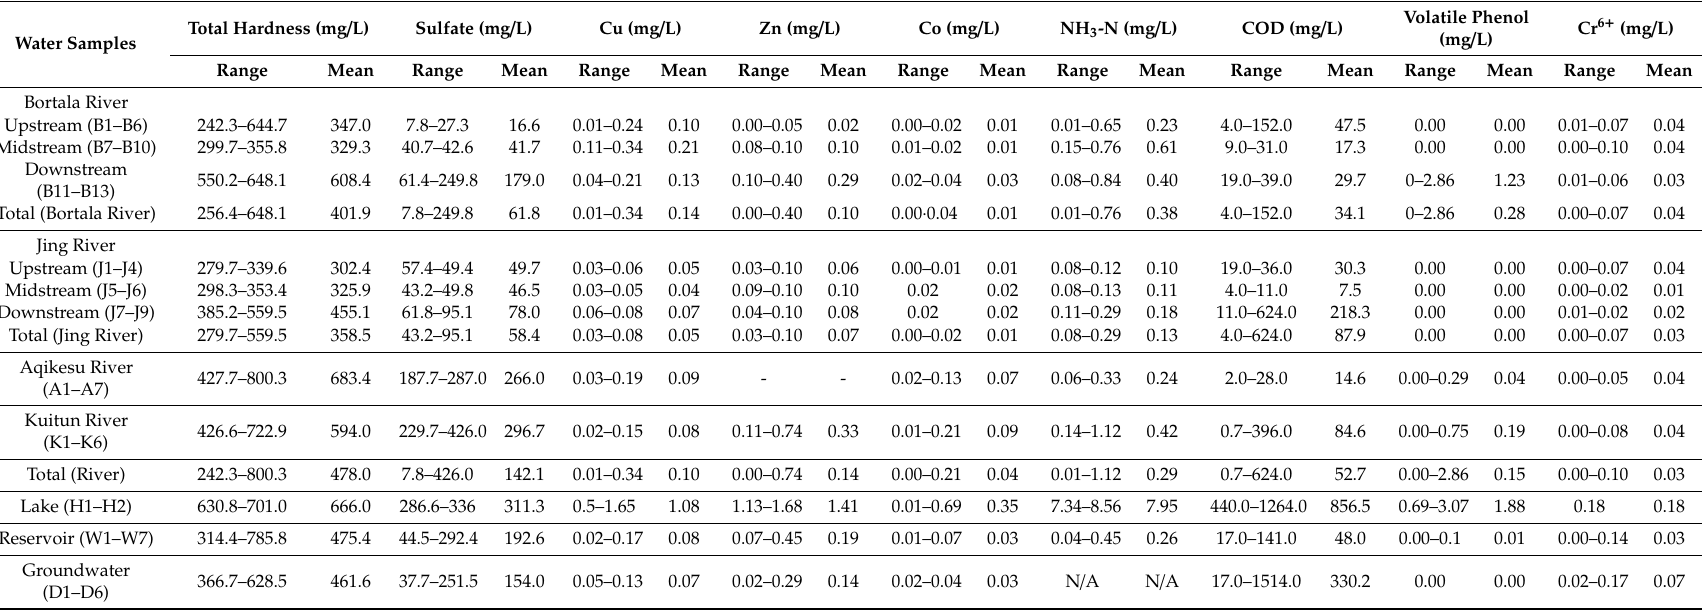
Table 5. The quality observations of surface water and groundwater. N / A—not